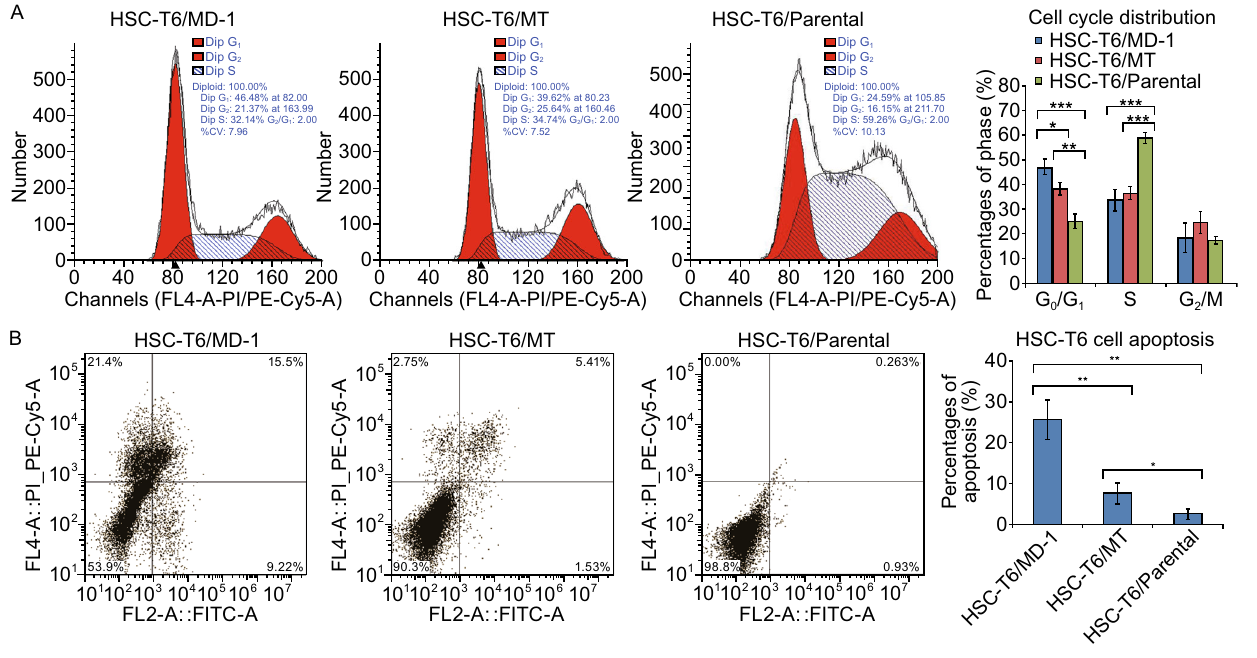
Figure 3. Inhibition of cell cycle and induction of apoptosis by MD-1 in HSC-T6 cells. (A) Left: The cell cycle distribution of HSC- T6 cells in the presence of MD-1 or MT at 62 μ mol/L was examined by fl ow cytometry. Right: Statistics for cell cycle distribution. * P < 0.05; ** P < 0.01; *** P < 0.001. (B) Left: The cell apoptosis rate was detected with fl ow cytometer in MD-1, MTand control